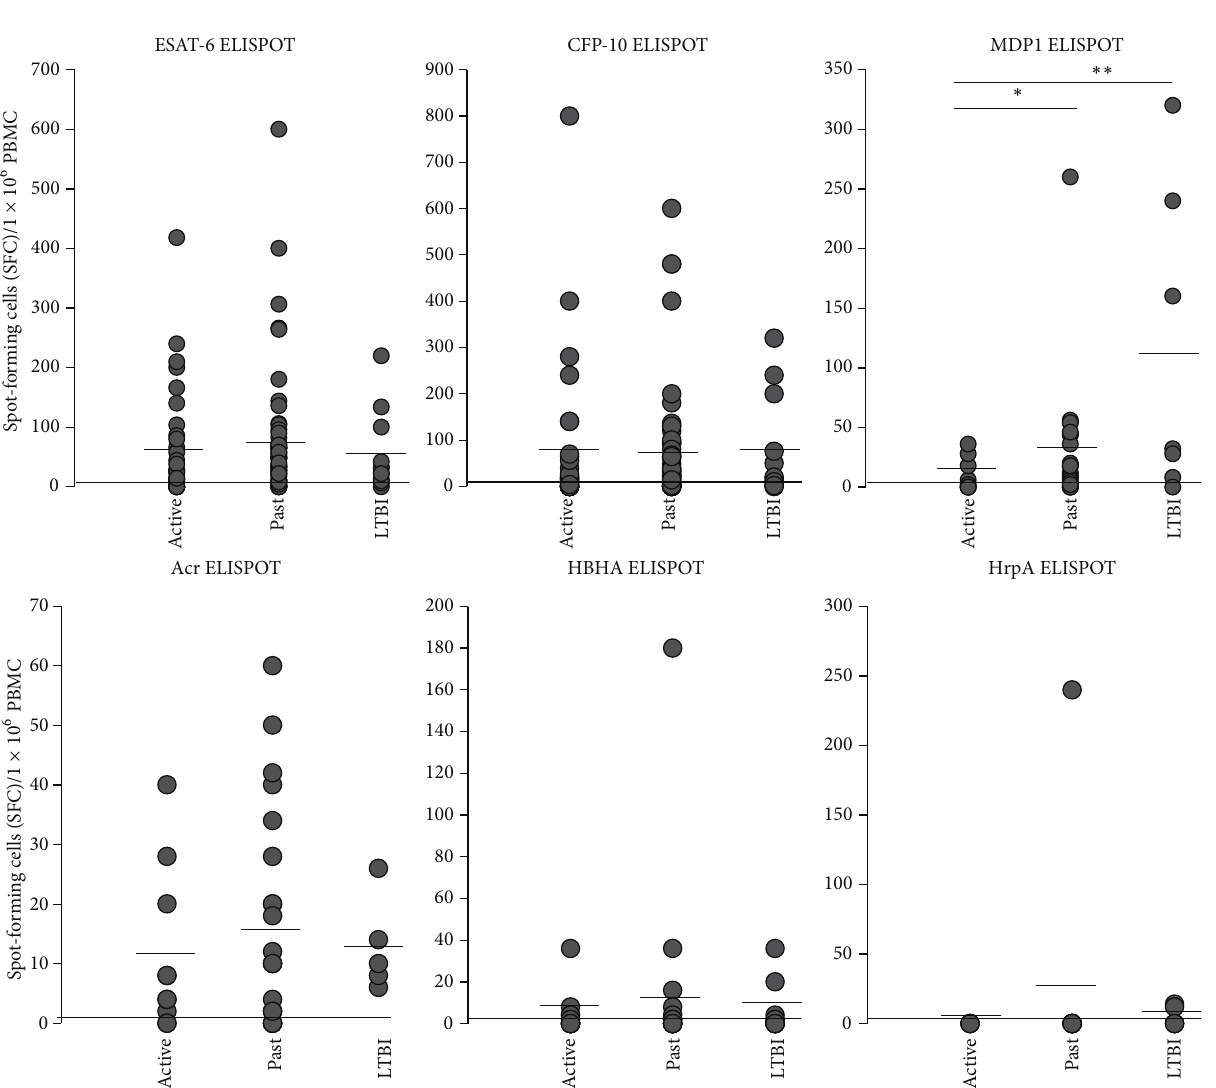
Figure 3: ELISPOT responses to Mtb antigens. ELISPOT SFCs against 6 antigens (ESAT-6, CFP-10, MDP1, Acr, HBHA, and HrpA) in active disease (labeled as “Active”), past disease (“Past”) and latent TB infection (“LTBI”). Data shown are the average of triplicate experiments. Vertical lines: mean values, ∗ 𝑃 < 0.05 , ∗∗ 𝑃 < 0.01